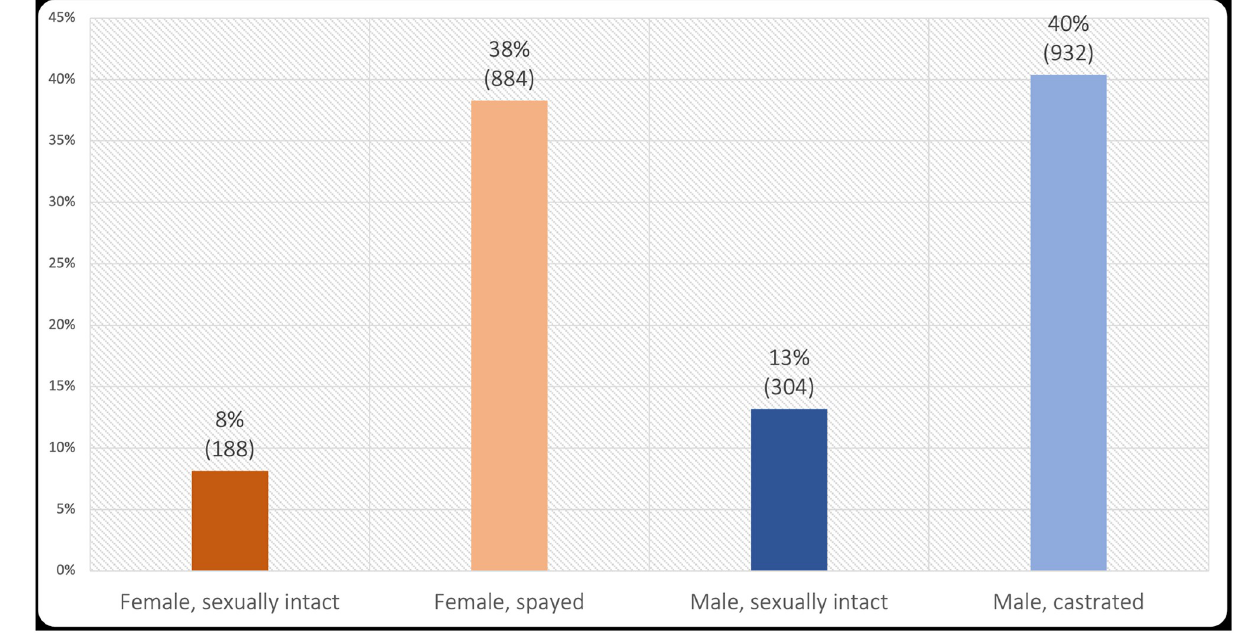
Fig 2. Sex/neuter status of 2,308 sampled